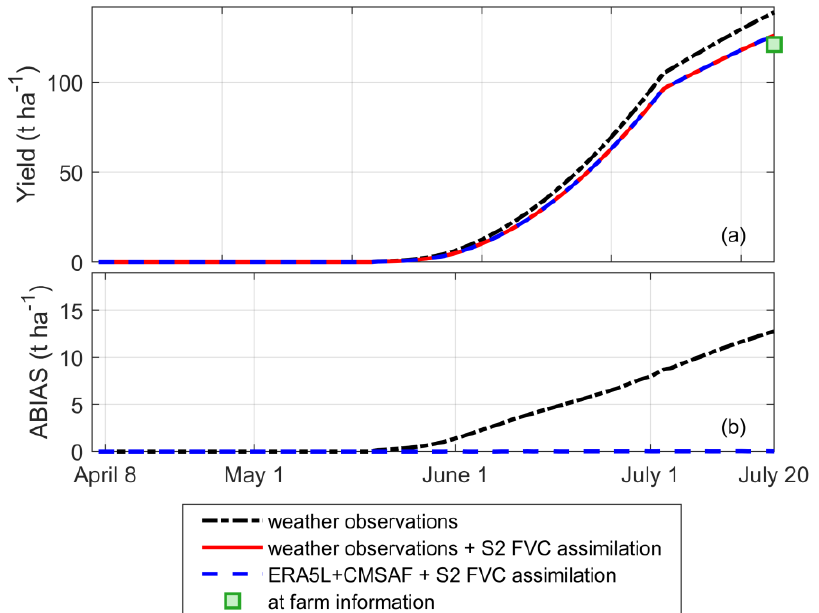
Figure 10. ( a ) Fresh yield evolution for different model inputs, as described in the legend; ( b ) Cumu- lative ABIAS (mm) of yield, computed using two different model inputs (i.e., weather observations and ERA5L + CMSAF + S2 FCV assimilation) versus the cumulative yield computed using weather observations + S2 FCV assimilation (best estimate) as model inputs. Table 7. Performance of the proposed model using different model inputs for yield estimation com- pared with the actual observed final yield.